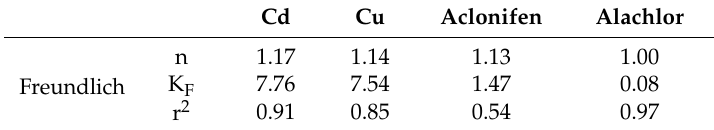
Table 5. Freundlich Coefficient for Cd, Cu, Aclonifen and Alachlor in the studied system.